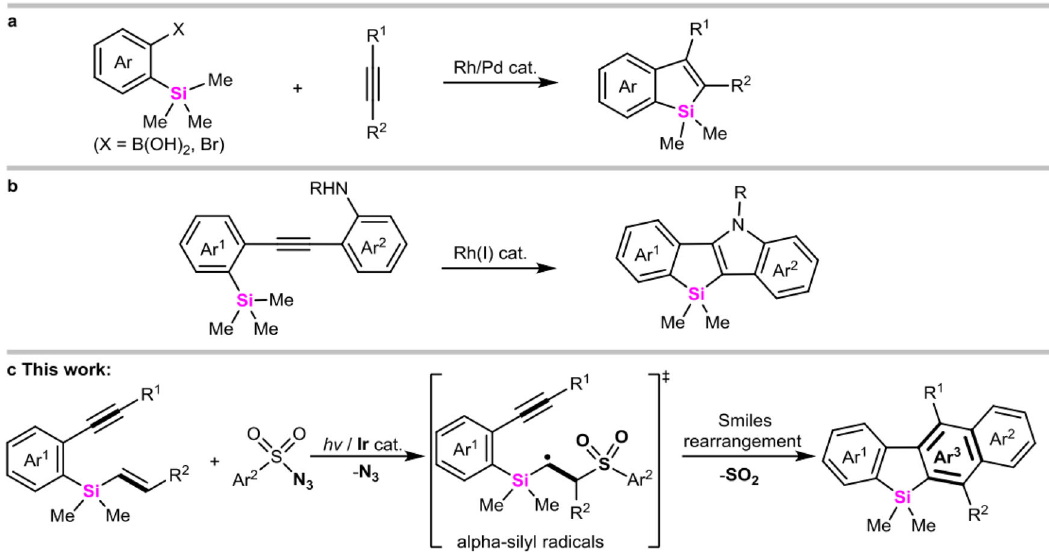
Fig. 1 Strategies to access benzosiloles. a Rh/Pd-catalyzed intermolecular cyclovinylation of arylalkylsilanes with alkynes. b Rh(I)-catalyzed intramolecular aminosilylation of ortho -alkynylarylsilanes. c Photocatalyzed carbocyclization of vinylsilanes with arylsulfonyl azides via alpha-silyl radical Smiles